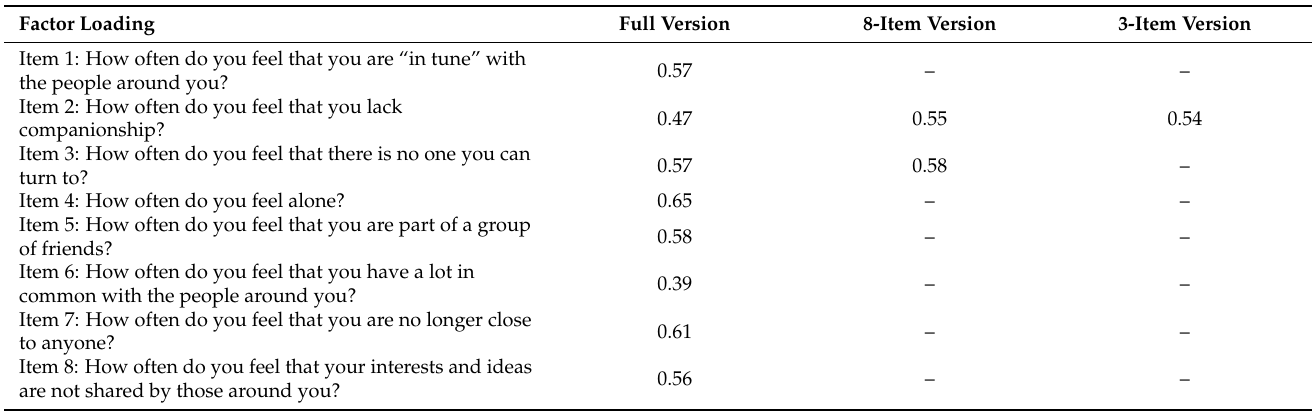
Table 3. Factor loading and fit indices in the confirmatory factor analyses of three versions of the UCLA Loneliness Scale (Version 3) ( n =